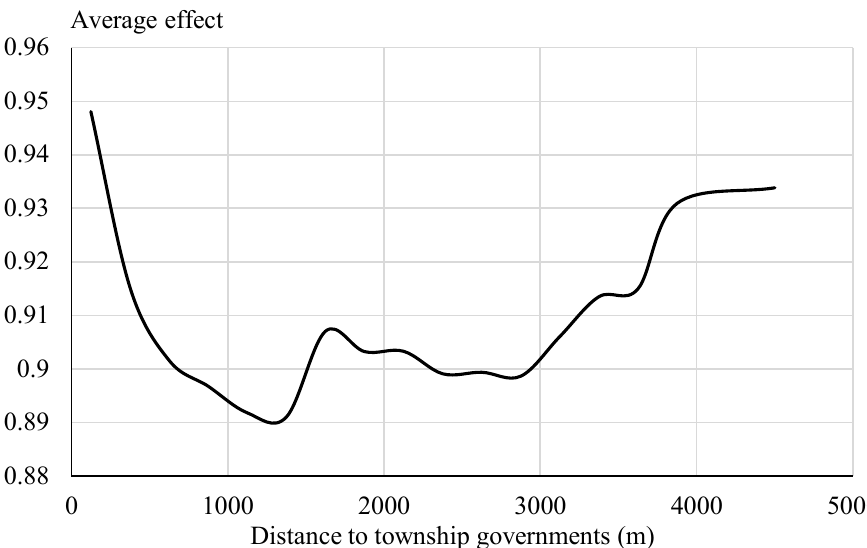
Figure 7. Average neighboring effect with distance to township governments.